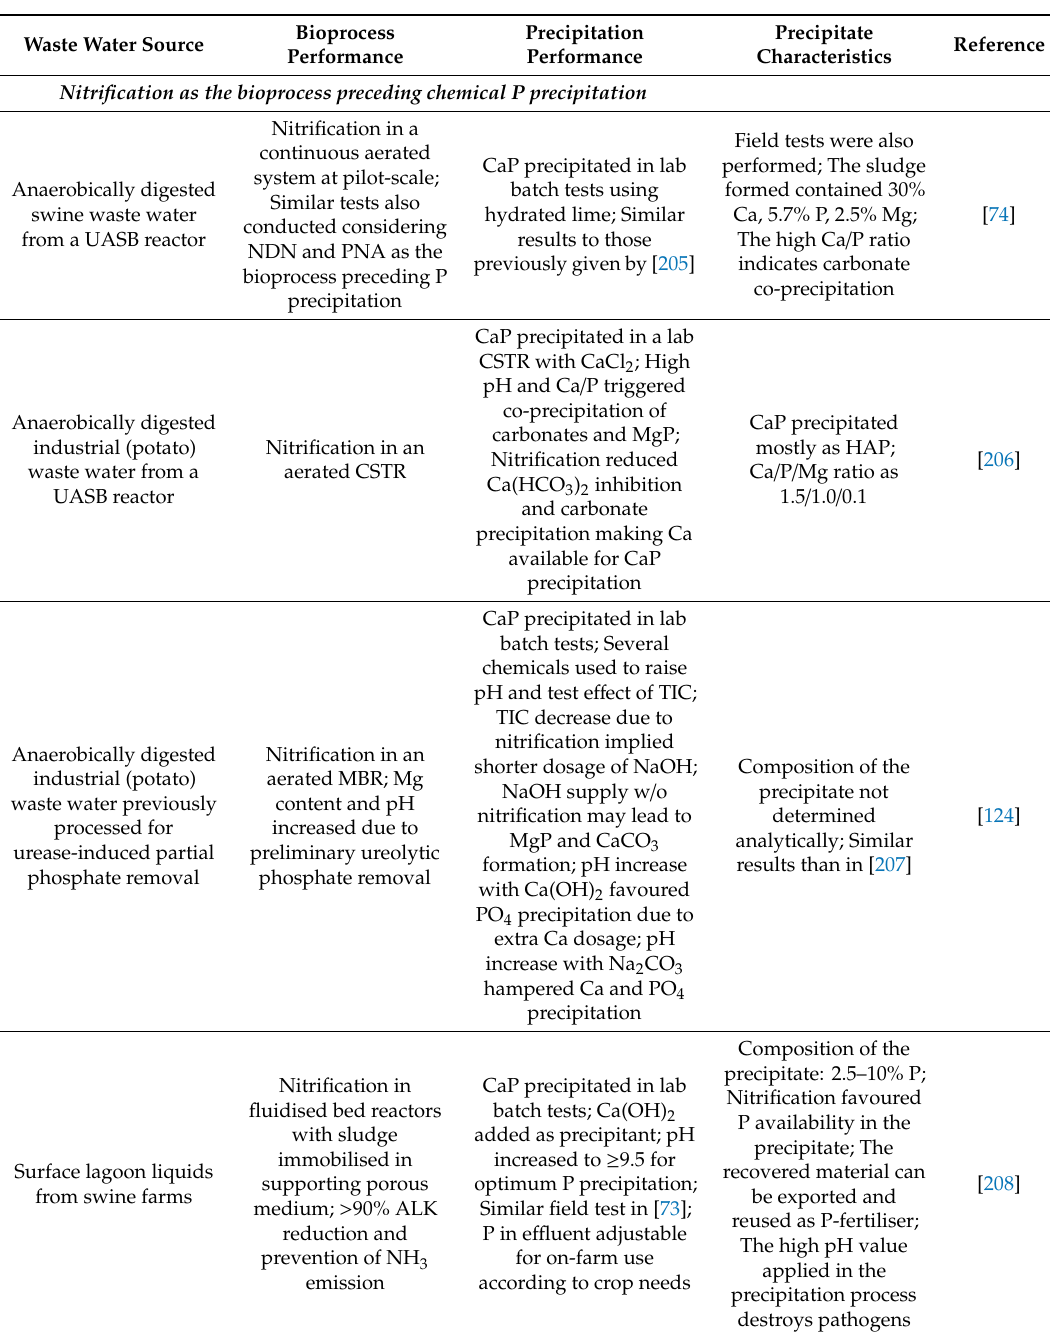
Table 4. Summary of experiences integrating biological N oxidation, or removal, followed by